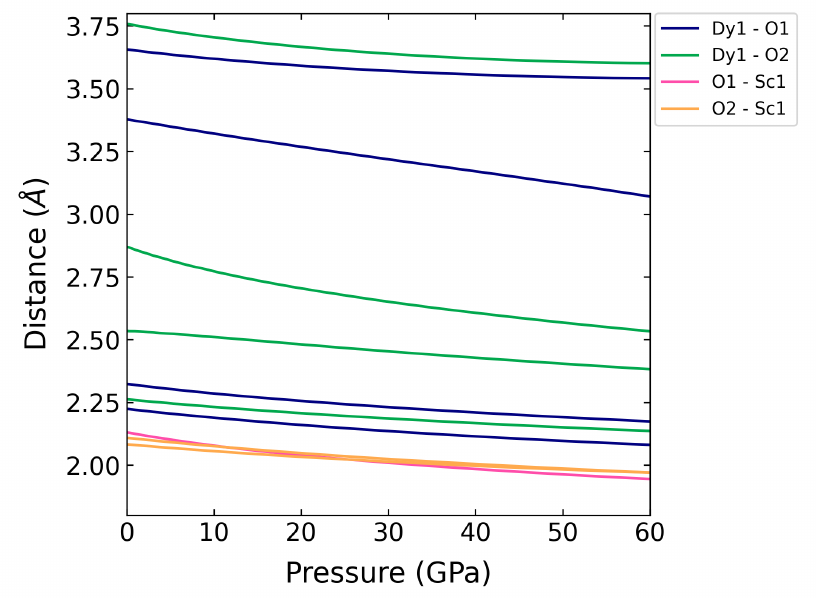
Figure 4. Evolution of interatomic distances with pressure in DyScO 3 perovskite. The O1-Sc1, O2-Sc1, and Dy1-O2 distances have all a multiplicity of two (each represented curve corresponds to two symmetrically equivalent but different